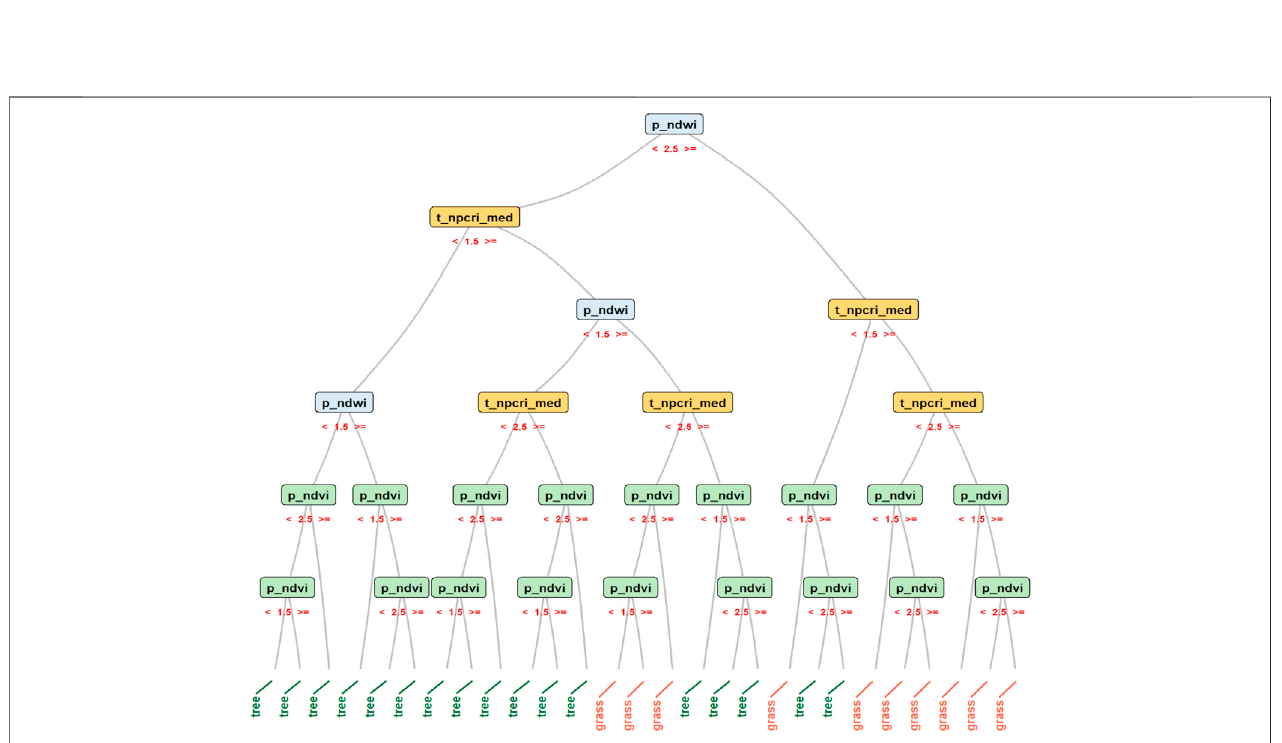
FIGURE 13 | This graphic visualizes the Random Forest Algorithm ’ s logic for a single Decision Tree for a simpli fi ed annotated dataset. The original dataset was fi ltered for data with the LULC classes of “ tree ” and “ grass; ” only three predictors were selected; and values of the predictors were grouped into three percentile bins. In this example, rules govern whether a branch in the Decision Tree ultimately leads to a pixel being classi fi ed as “ grass. ” Generally, (A) p_ndwi must be ≥ 2.5; and (B) t_npcri_med must be ≥ 1.5. If (A) is true and (B) is false, then p_ndvi must be < 1.5. If (A) and (B) are false, then p_ndwi must be > 1.5 and p_ndvi must be < 2.5. Simulations from our ensemble of Random Forest models are the net, probabilistic result from thousands of such trees for all predictors and response variables in our annotated dataset.